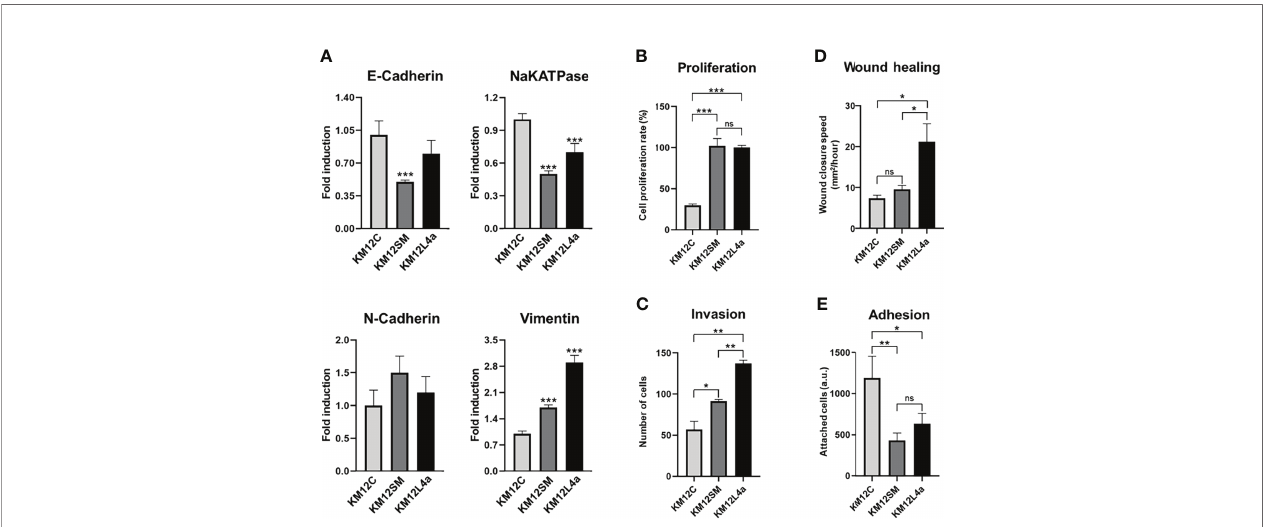
FIGURE 2 | Characterization of metastatic KM12SM and KM12L4a CRC cells in comparison to the isogenic non-metastatic KM12C CRC cells. (A) qPCR analysis showed the upregulation of mesenchymal markers (N-cadherin and vimentin) and the downregulation of epithelial markers (E-cadherin and NaKATPase) in both metastatic CRC cells compared to KM12C cells. (B – E) In vitro functional cell-based assays showed that metastatic CRC cells possessed increased tumorigenic and metastatic properties than non-metastatic KM12C CRC cells. (B) Proliferation. (C) Invasion. (D) Wound healing. (E) Adhesion. * p value < 0.05; ** p value < 0.01; *** p value <